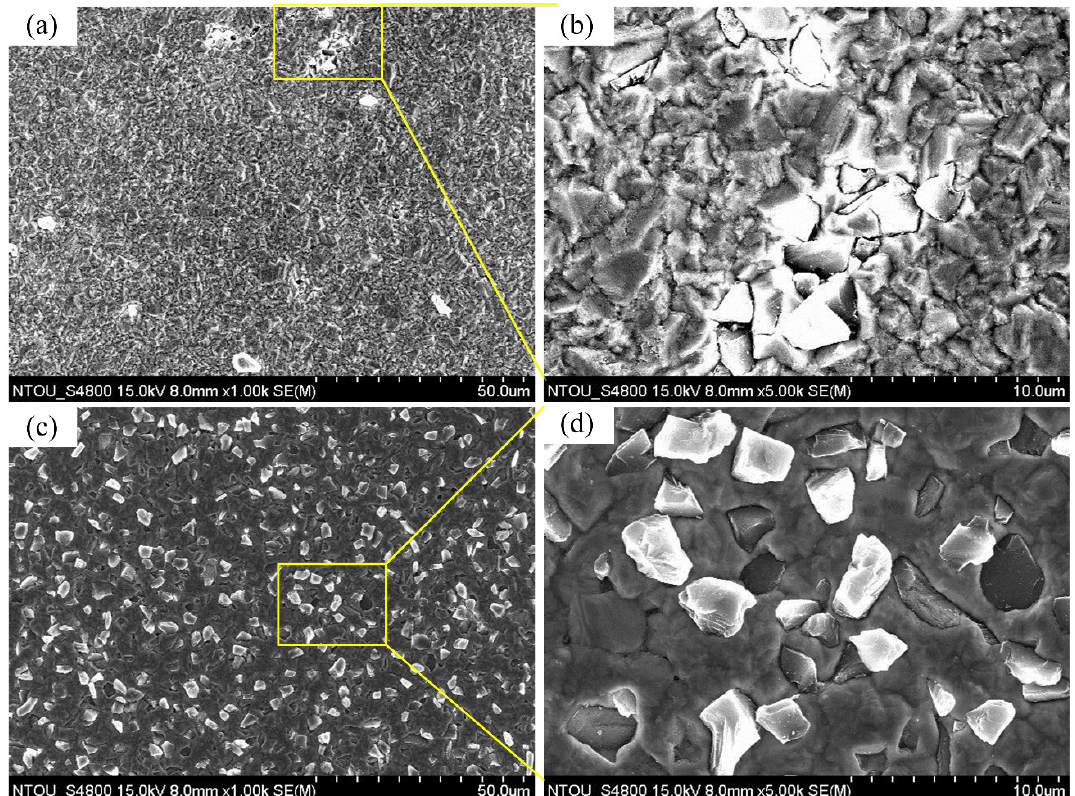
Figure 6. Surface morphologies of specimen A and specimen B: ( a ) Surface of specimen A under 1000× magnifications, ( b ) surface of specimen A under 5000× magnifications, ( c ) surface of specimen B under 1000× magnifications, and ( d ) surface of specimen B under 5000× magnifications.